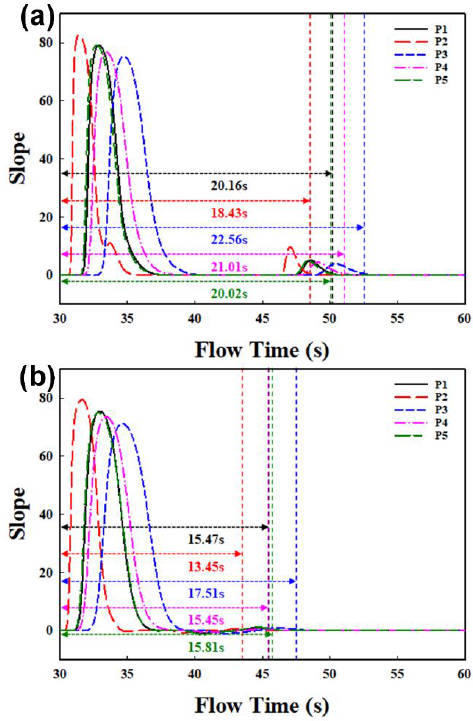
Figure 8. The slopes of slurry mass fraction and the relevant slurry saturation time on the ( a ) R0 pad, and ( b ) R32 pad in the 100-mm wafer polisher.